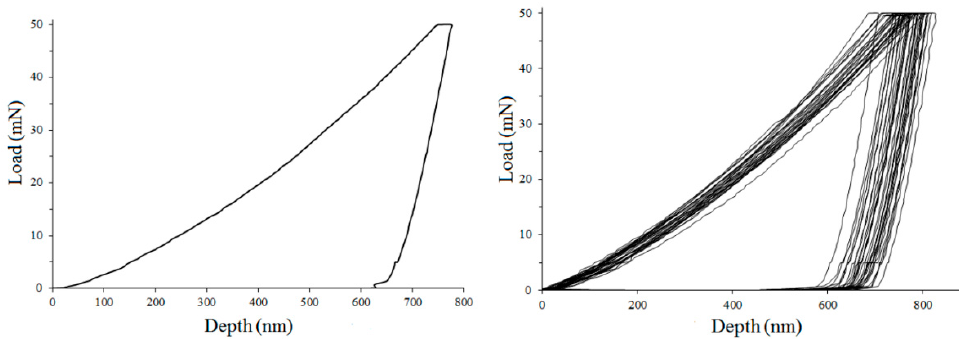
Figure 12. Typical stress–strain plots for nanoindentation test.